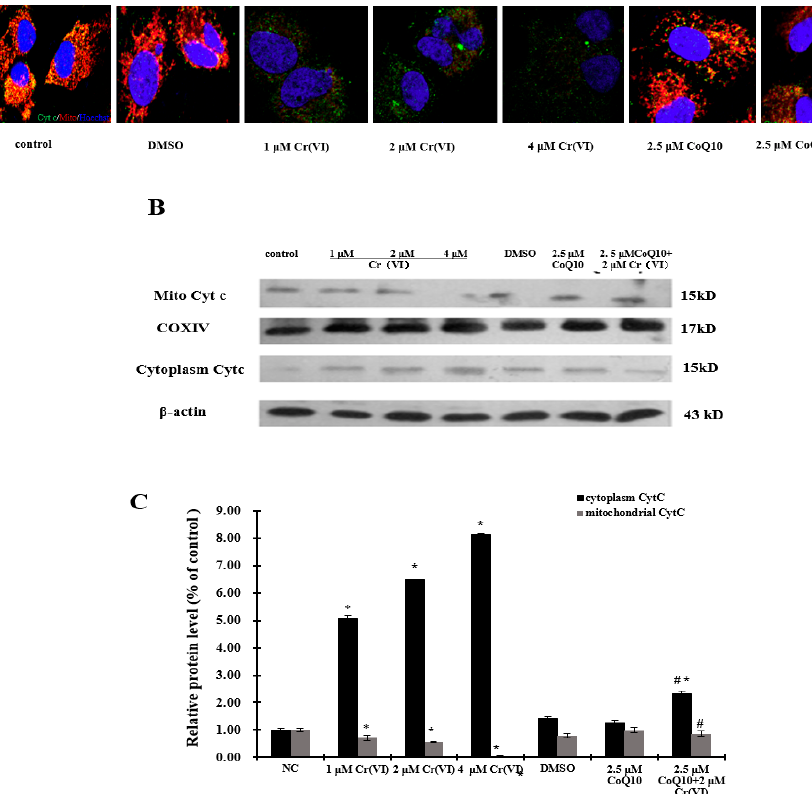
Figure 5. Cr(VI) induces cytochrome c release from the mitochondria to the cytoplasm. ( A ) Merged images of the mitochondria (red), Cyt c (green) and nucleus (blue) after exposure to Cr(VI) for 24 h in L-02 hepatocytes. Cyt c (green) and mitochondria (red) localization (yellow) indicates that Cyt c is still inside mitochondria. The separation of Cyt c and mitochondria suggests that Cyt c is no longer within the mitochondria and has been released into the cytoplasm, scale bar: 10 µ m; ( B ) CoQ10 prevents Cyt c release to the cytoplasm; Cyt c protein expression was measured by Western blotting. COXIV and β -actin were used as loading controls; ( C ) The relative protein levels were calculated by Image J software. Experiments were repeated three times and showed similar